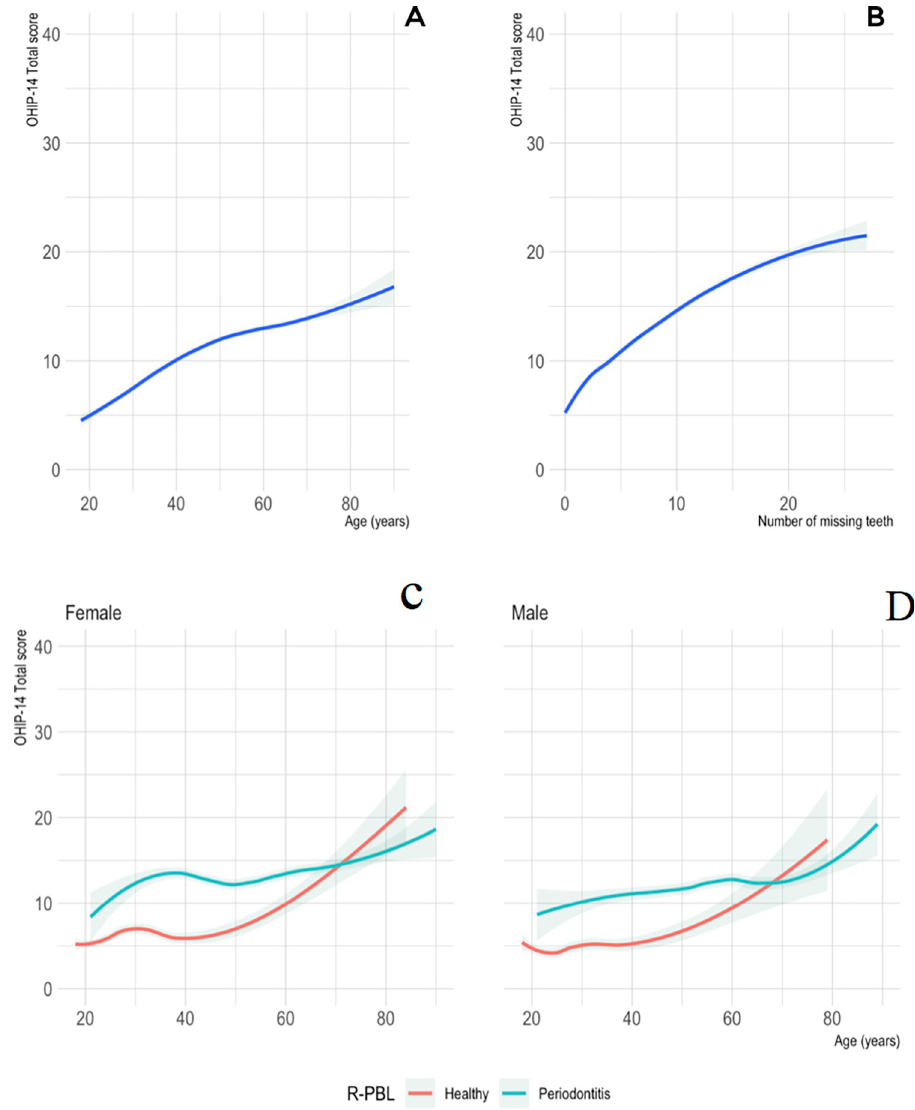
Fig 2. Graphical representation of the association of age and number of missing teeth with OHRQoL. When analysing the overall sample, OHRQoL show a growing trend with age ( A ) and the number of missing teeth ( B ). Regardless sex, radiographically screened periodontitis exhibited an average decrease in OHRQoL than healthy individuals in both females ( C ) and males ( D ).